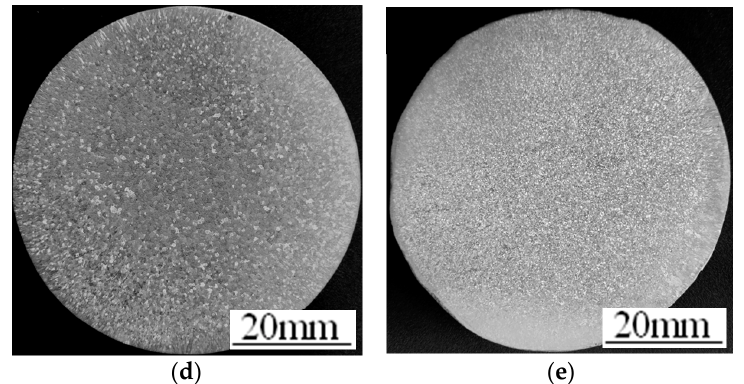
Figure 4. Effects of different additions of Al-5Ti-0.62C-0.2Ce master alloy on grain size of solidified commercial pure aluminum sample (holding for 5 min): ( a ) unmodified; ( b ) 0.2%; ( c ) 0.3%; ( d ) 0.5%; and ( e ) 0.7%.